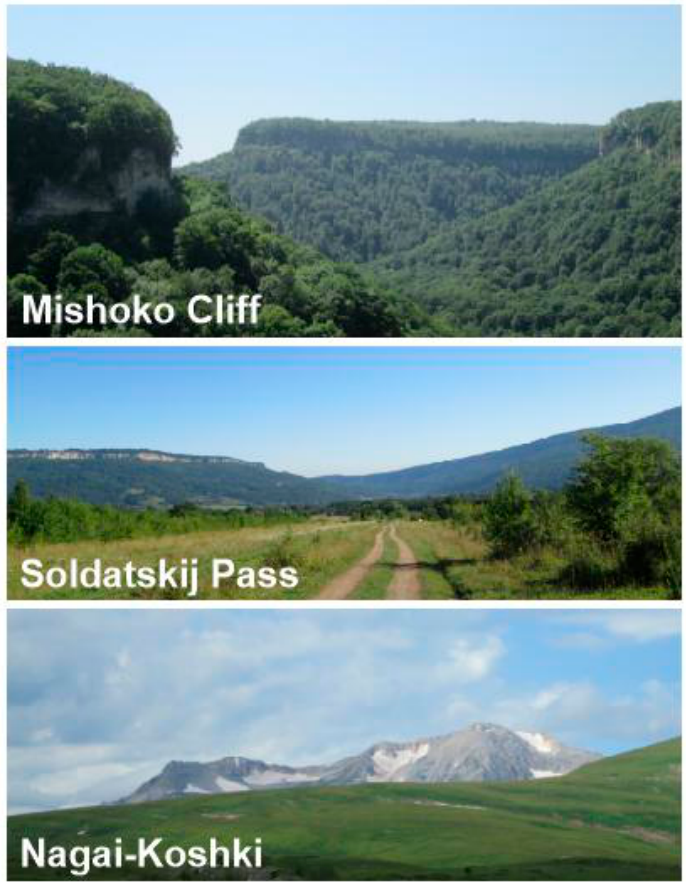
Figure 3. Panoramic views from the studied viewpoint geosites/geomorphosites.